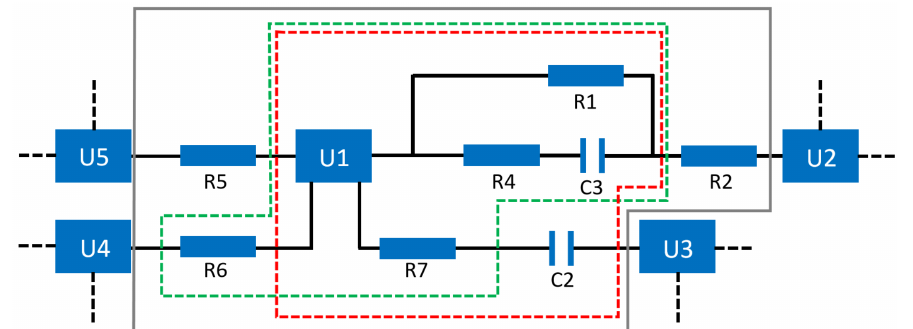
Figure 8. How to compute TP, FN, FP, and TN. Ground truth set A is in the green block, partition set B from the proposed method is in the red block, and components set in the gray block are the whole candidate set C . Better viewed in color. TP = A ∩ B , FN = A − A ∩ B , FP = B − A ∩ B , TN = C − A ∪ B .